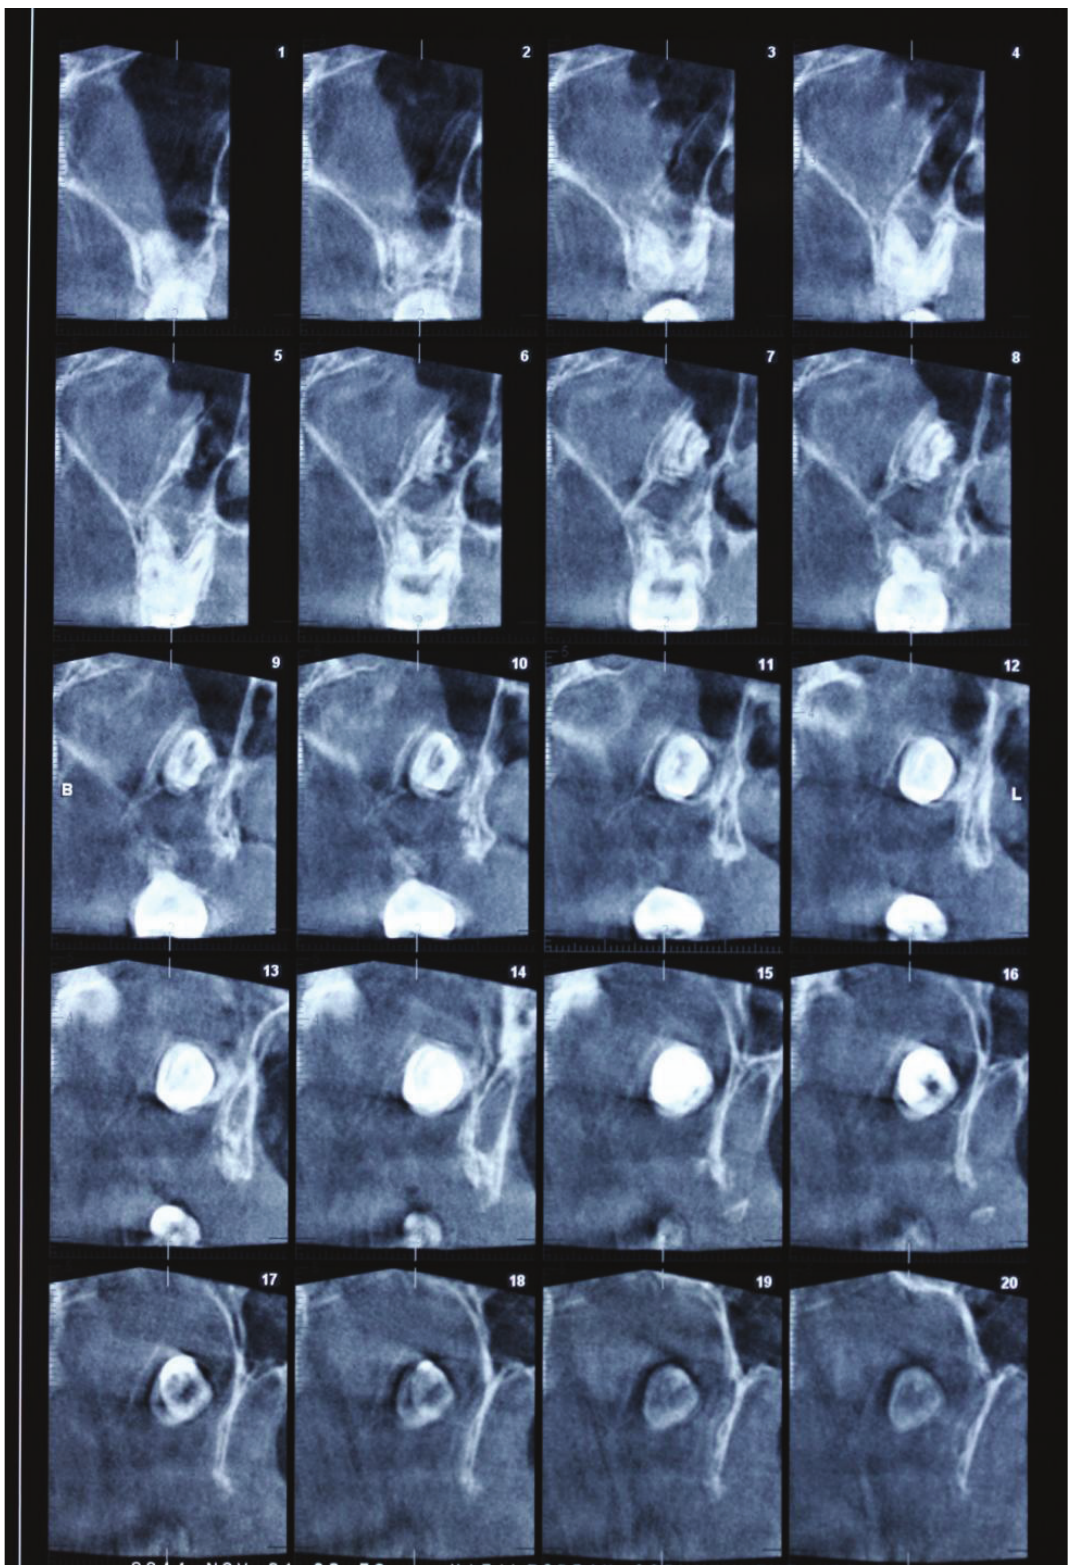
Figure 2: CT revealed that the tooth was located superiorly between the distal margin of maxillary tuberosity and the anterior border of lateral pterygoid